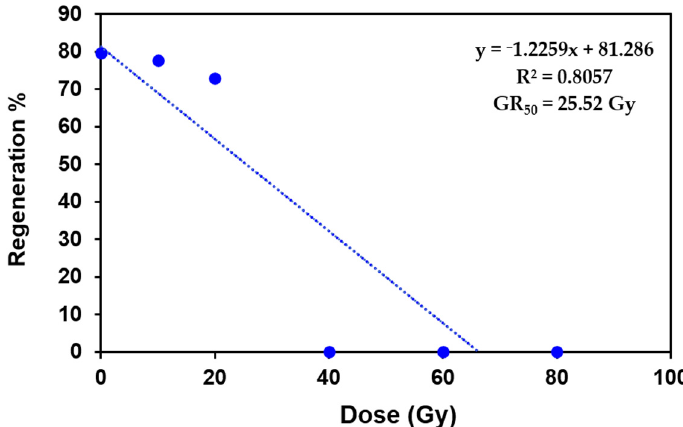
Figure 1. Growth response of protocorm-like bodies (PLBs) of Dendrobium after gamma irradiation. PLBs of Dendrobium ‘Emma White’ were irradiated with gamma ray doses of 10, 20, 40, 60 and 80 Gy and incubated at 22 ± 2 °C and 65–70% relative humidity with 16 h photoperiod. An unirradiated set of PLBs was maintained as control. After three and six months of irradiation, growth response of irradiated PLBs based on proliferation percentage ( A ) and regeneration percentage ( B ) was recorded for each treatment. Data represent mean values ± standard error ( n = 10). Means with different lower-case letters (a, b, c, d) are significantly different at p < 0.05 (Duncan’s Multiple Range Test).